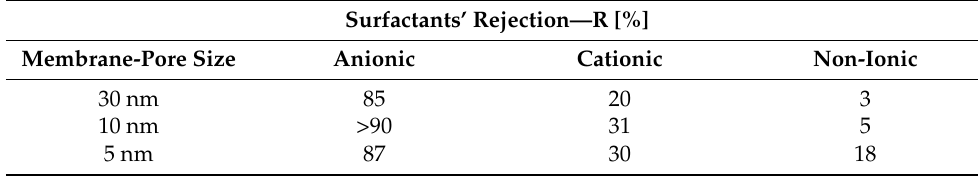
Table 4. Rejection (R) of surfactants in experiments 1, 2 and 3 for membrane-pore sizes of 30, 10 and 5 nm, respectively (5% standard